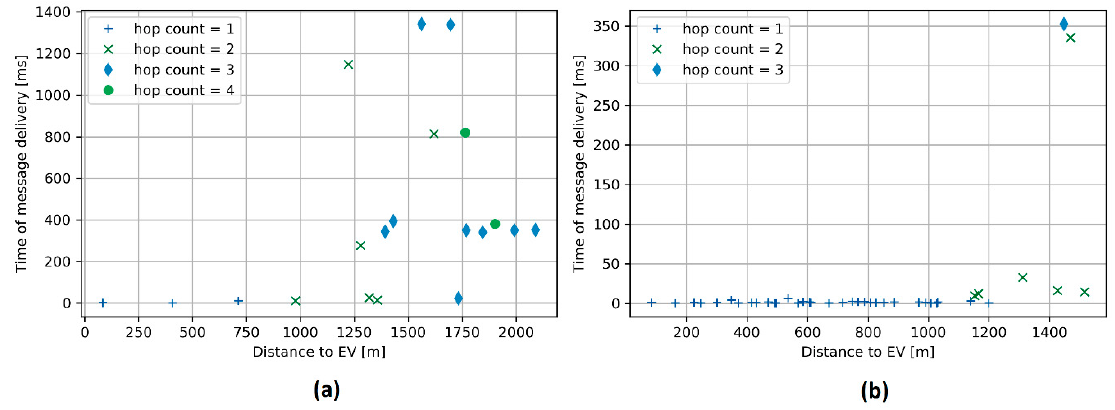
Figure 7. The delivery time of the first message versus the distance between the vehicle and the EV at the time when the first message was received in ( a ) the Žilina scenario and in ( b ) the Bratislava scenario.